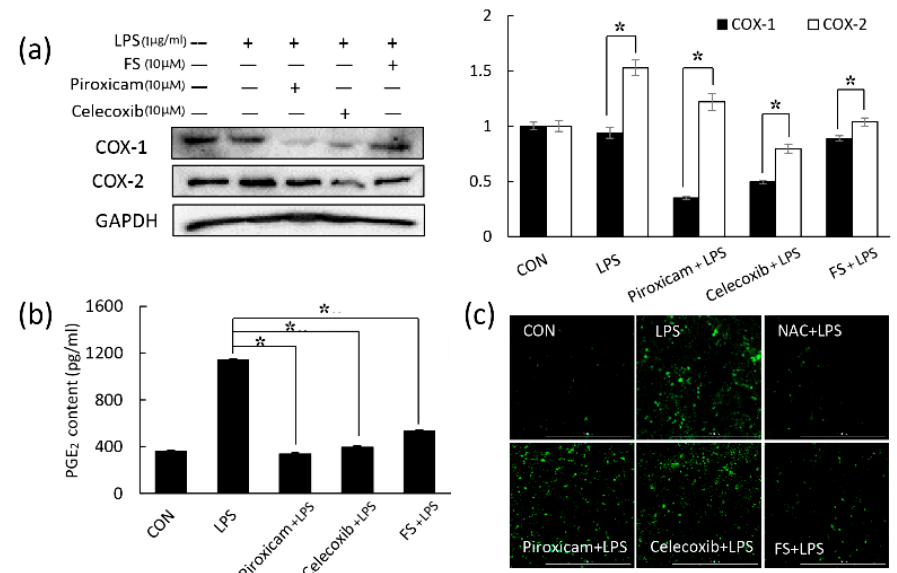
Figure 2. Comparison between FS and COX-1 / COX-2 inhibitors in HaCaT cells. ( a ) In order to compare the activity of FS on COX-1 and COX-2, 10 µ M piroxicam, 10 µ M celecoxib, and 10 µ M FS were used to inhibit COX-1 and COX-2 respectively. ( b ) The e ff ects of piroxicam, celecoxib, and FS on PGE 2 release were detected. ( c ) To compare the anti-oxidative activities of piroxicam, celecoxib, and FS, DCF-DA staining was used to detect the reactive oxygen species (ROS). A total of 5 µ M NAC ( N -acetyl- L -cysteine) was used to scavenge ROS as a positive control. * p -value < 0.05.